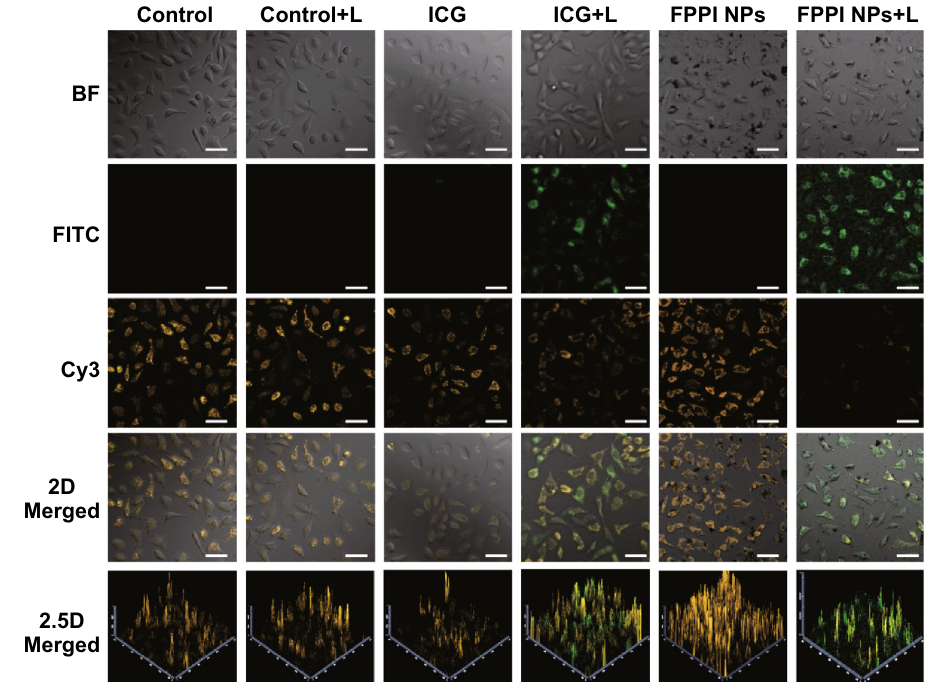
Fig. 6 Change in mitochondrial membrane potential of HeLa cells after treatment with ICG or FPPI NPs (at an equivalent ICG concentration of 6 l g mL - 1 ) for 4 h and NIR laser irradiation (‘‘L’’) for 10 min where applicable. After standard JC-1 staining for 30 min, the apoptosis status was determined by fluorescence images captured via the Cy3 channel for JC-1 aggregates and FITC channel for JC-1 monomers (scale bars: 50 l